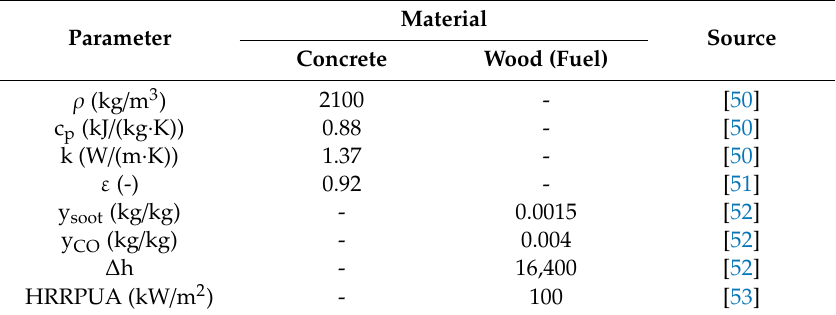
Table 2. Thermo-physical properties of materials used in the simulations.